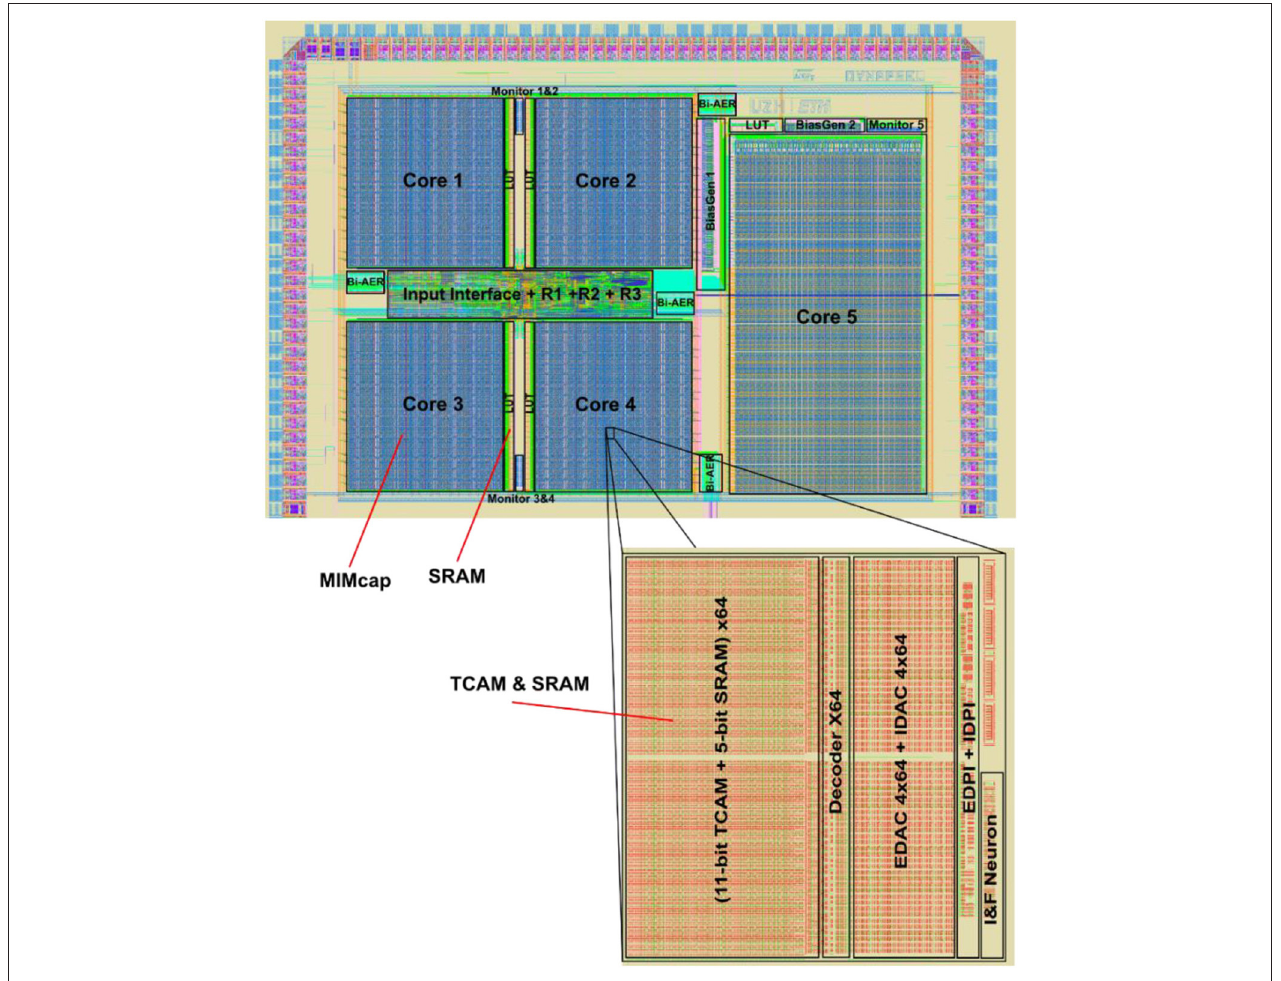
FIGURE 17 | Dynap-SEL chip, fabricated using a 28nm FDSOI process. It occupies an area of 7.28 mm 2 and comprises four non-plastic cores and one plastic core. Each non-plastic core has 256 analog I&F neurons and 64k TCAM-based synapses arranged in 2D array (each synapse address is identified by an 11-bit TCAM, and each synapse type and weight areidentified by a 5-bit SRAM). Each plastic core has 64 analog I&F neurons, 8k digital plastic synapses, 4k digital non-plastic synapses, and 256 virtual